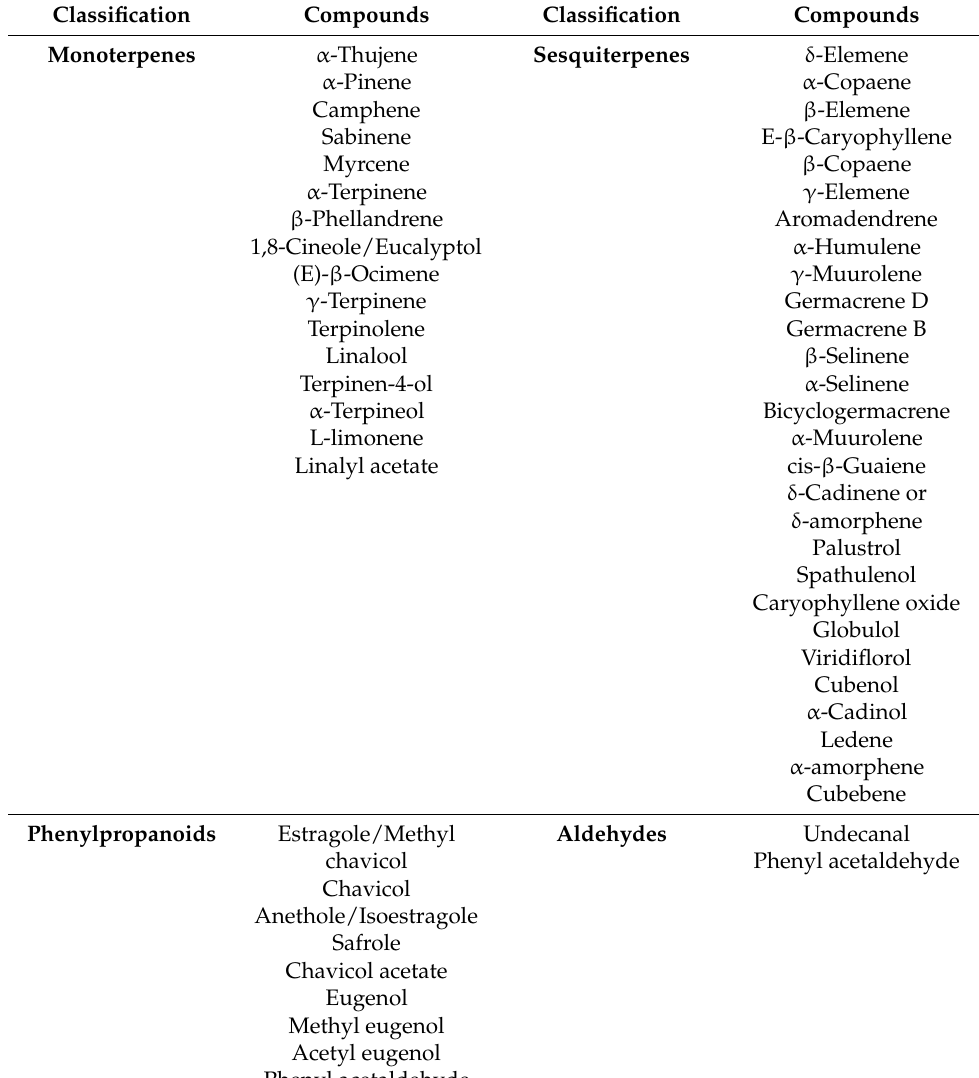
Table 1. List of phytochemicals identified from betel leaf essential oil